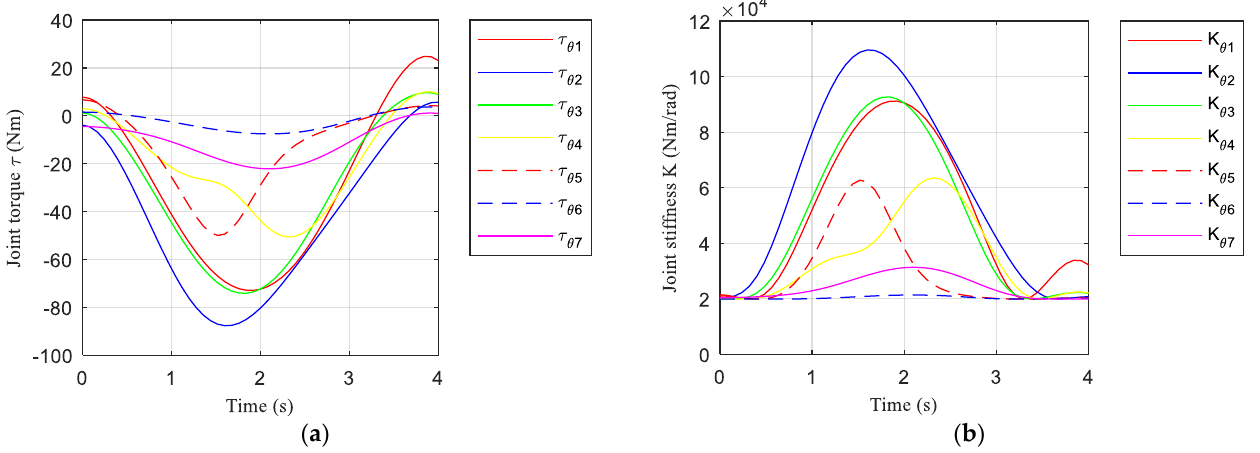
Figure 12. The real-time joint torque and joint stiffness of each joint of the humanoid manipulator. ( a ) The real-time joint torque; ( b ) The real-time joint stiffness.